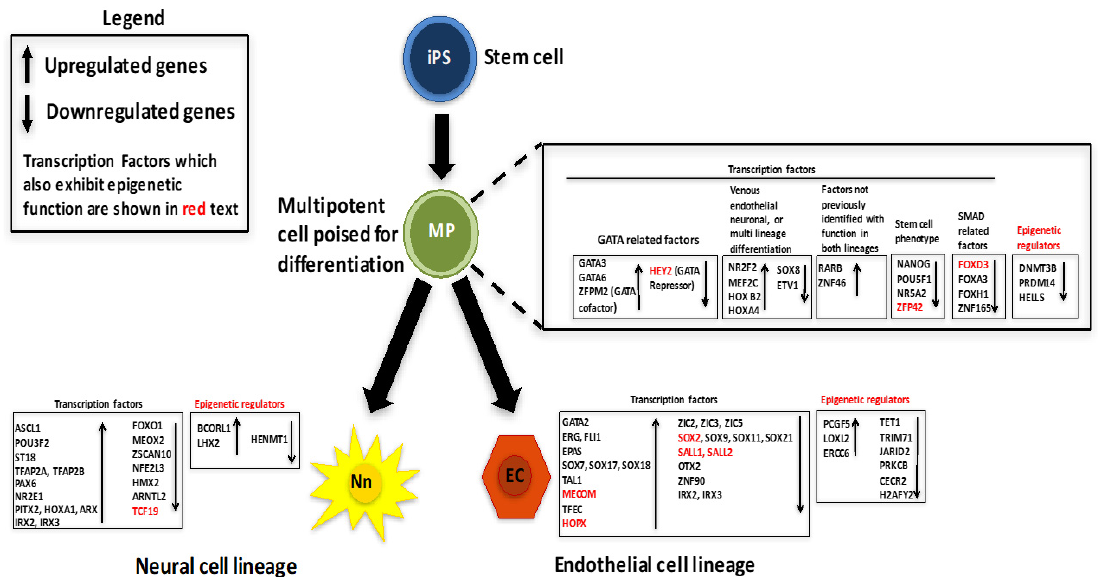
Figure 3. Schematic representation of differentially expressed transcription factors/cofactors and epigenetic regulators when cells acquire the ability to differentiate, and when they are differentiated to EC vs. Nn lineages . iPS, a cell that has stem cell phenotype; MP (multipotent), a cell that is poised to differentiate towards all or multiple lineages. Transcription factors that also exhibit epigenetic function are shown in red